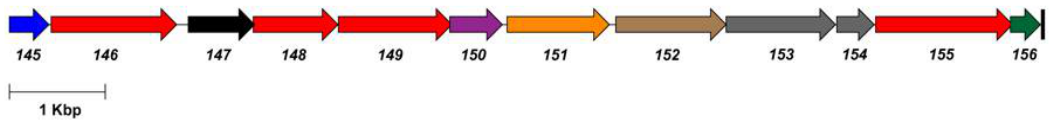
Figure 5. Gene map of the 10.8-kb region of SP-15 that encodes numerous host-related genes involved in carbohydrate biosynthesis (in red). Color code: blue, ssDNA binding protein; black, HNH homing endonuclease; purple, diguanylate cyclase; brown, teichoic acid biosynthetic protein; grey, hypothetical proteins; and green, thioredoxin. The terminal black box corresponds to a rho-independent terminator.